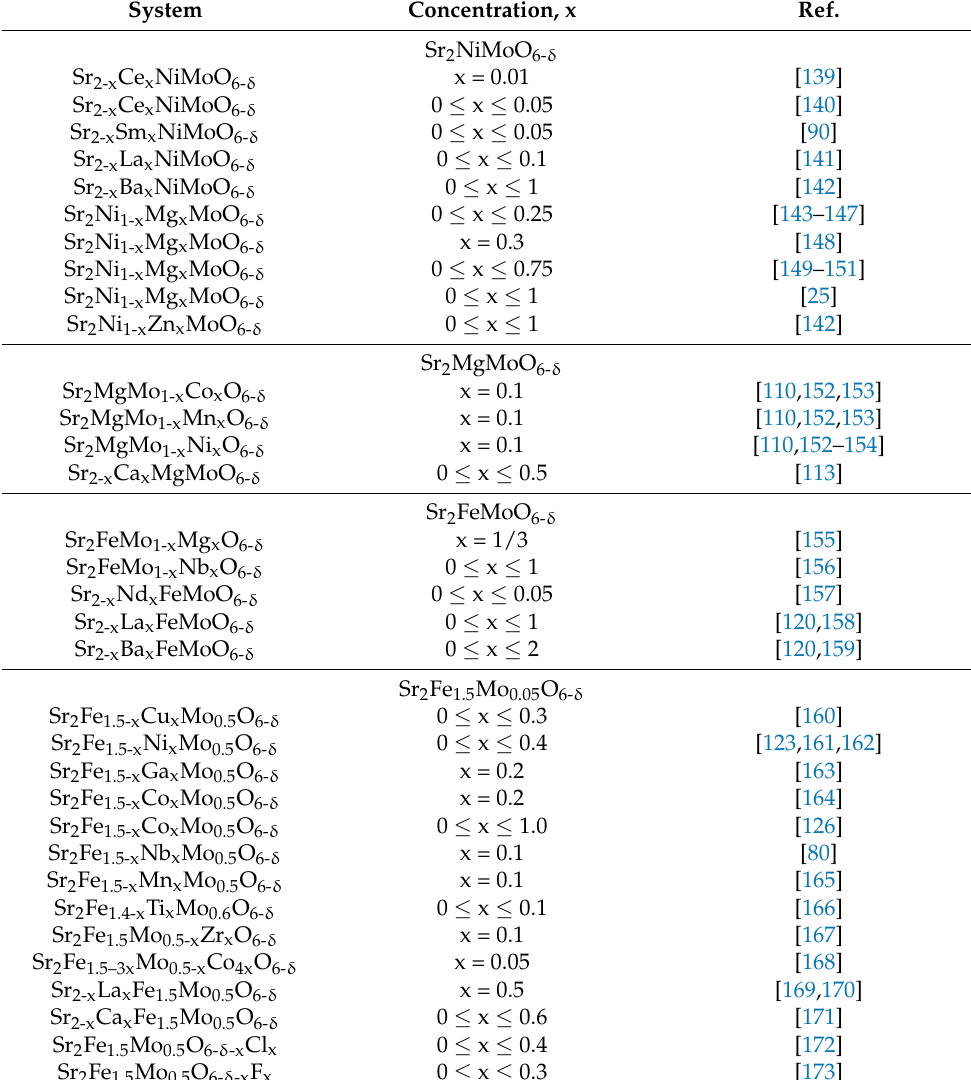
Table 8. Doping strategies performed for tailoring the functional properties of Sr 2 MMoO 6- δ .